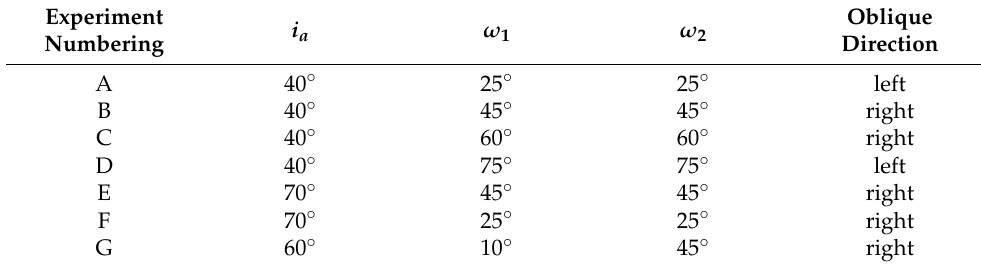
Table 2. Experiment parameters for the physical